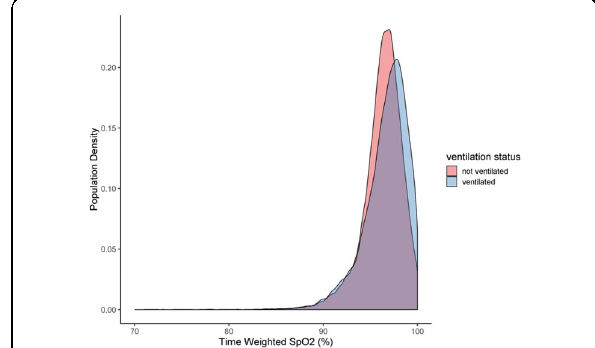
Fig. 1 (abstract 000290). Mechanically ventilated versus non- mechanically ventilated patients